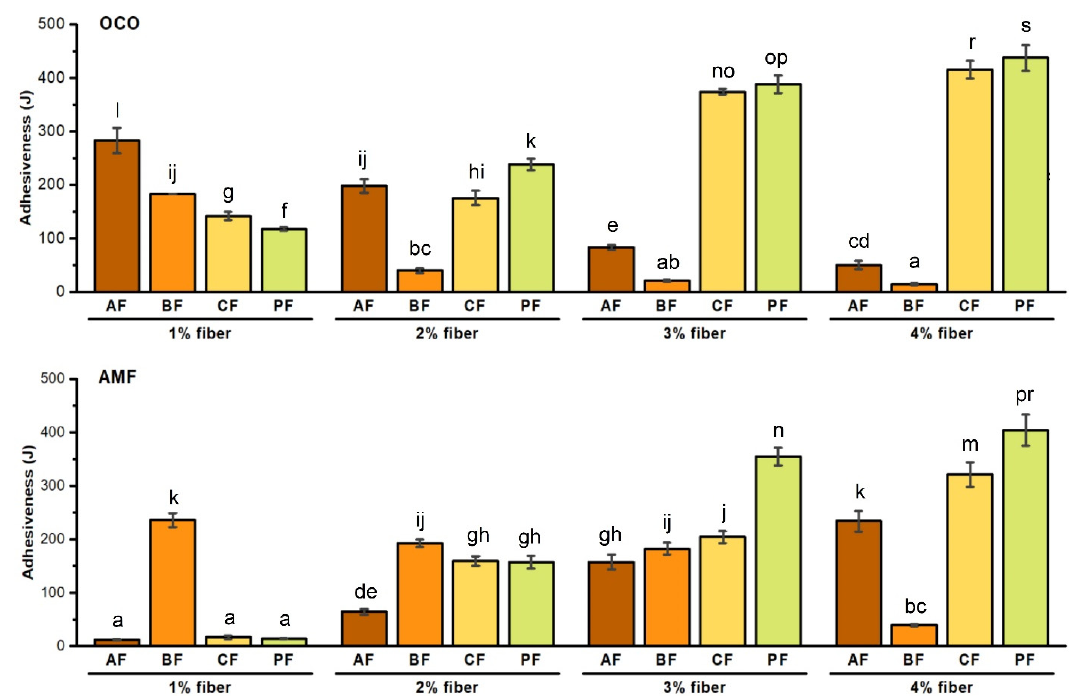
Figure 2. Effect of fiber type and concentration on adhesiveness of PCS (processed cheese sauces) obtained on the basis of AC (acid casein) and WPC80 (whey protein concentrate) with OCO (organic coconut oil) or AMF (anhydrous milk fat). Letters (a–p,r,s) indicate significant differences at p < 0.05.